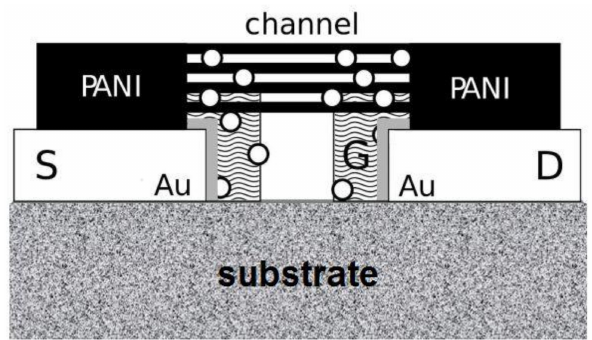
Figure 1. A conceptual scheme of the nanodetector with a mechanism resembling an open-gate ion-sensitive organic field-effect transistor (ISOFET). The “channel” is made of polyaniline nanofibers, and the functional organic monolayer is marked as a “gate” G, which is insulated by a part of the self-assembled monolayer (SAM), formed of alkyl components (here, the thin grey layer is in direct contact with Au electrodes; o metal ions).